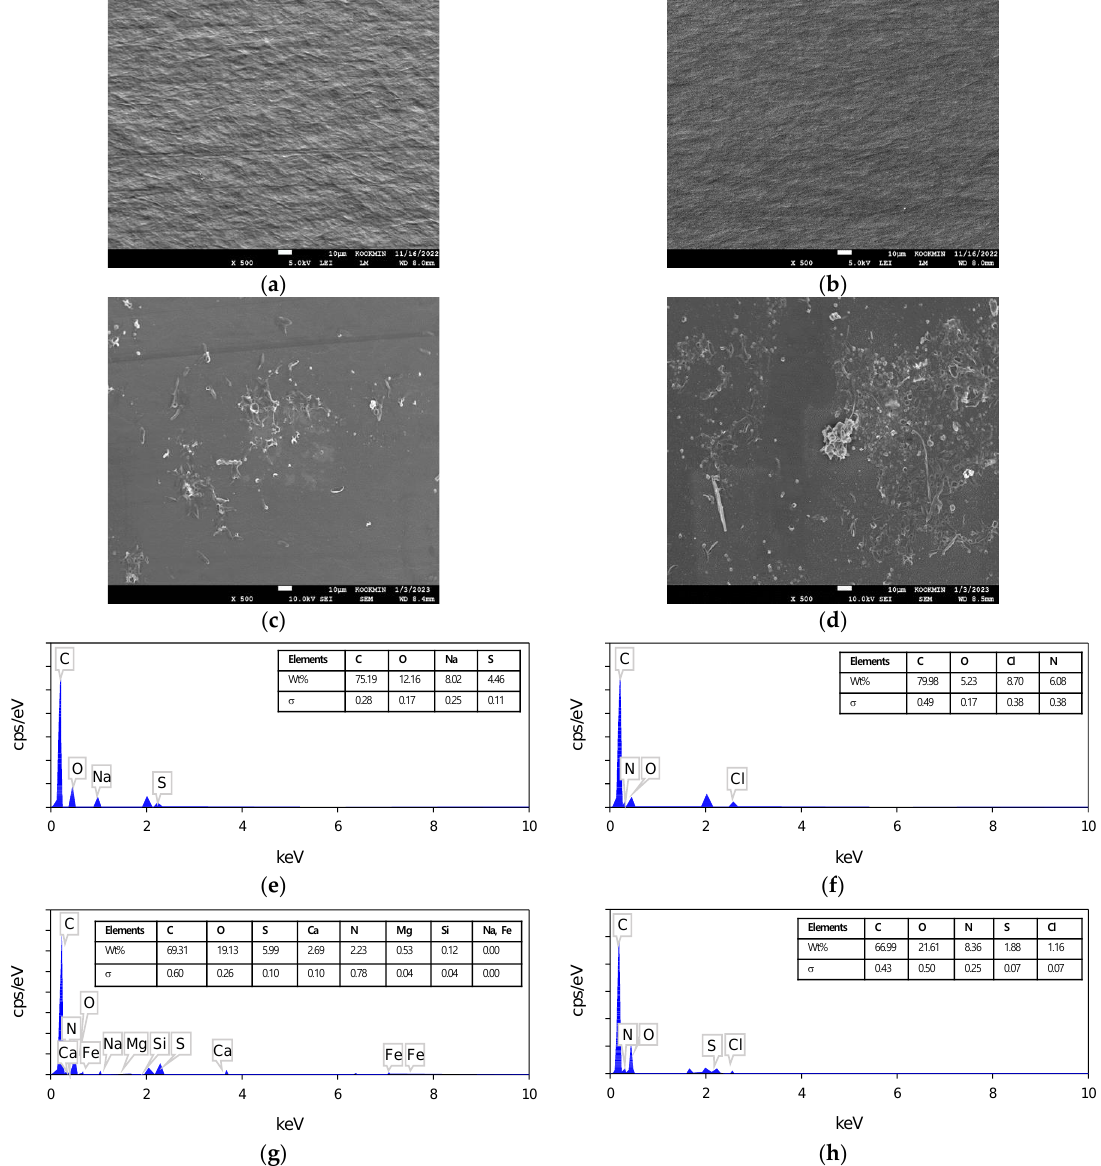
Figure 12. FE-SEM images and EDS spectrum of the ion exchange membrane surface before and after use: ( a ) and ( b ) virgin cation and anion exchange membrane; ( c ) CEM fouled by Ca, N, Mg, Si and S; ( d ) AEM fouled by S at 500 times, respectively; ( e – h ) show the EDS spectra of ( a – d ), respec- tively.